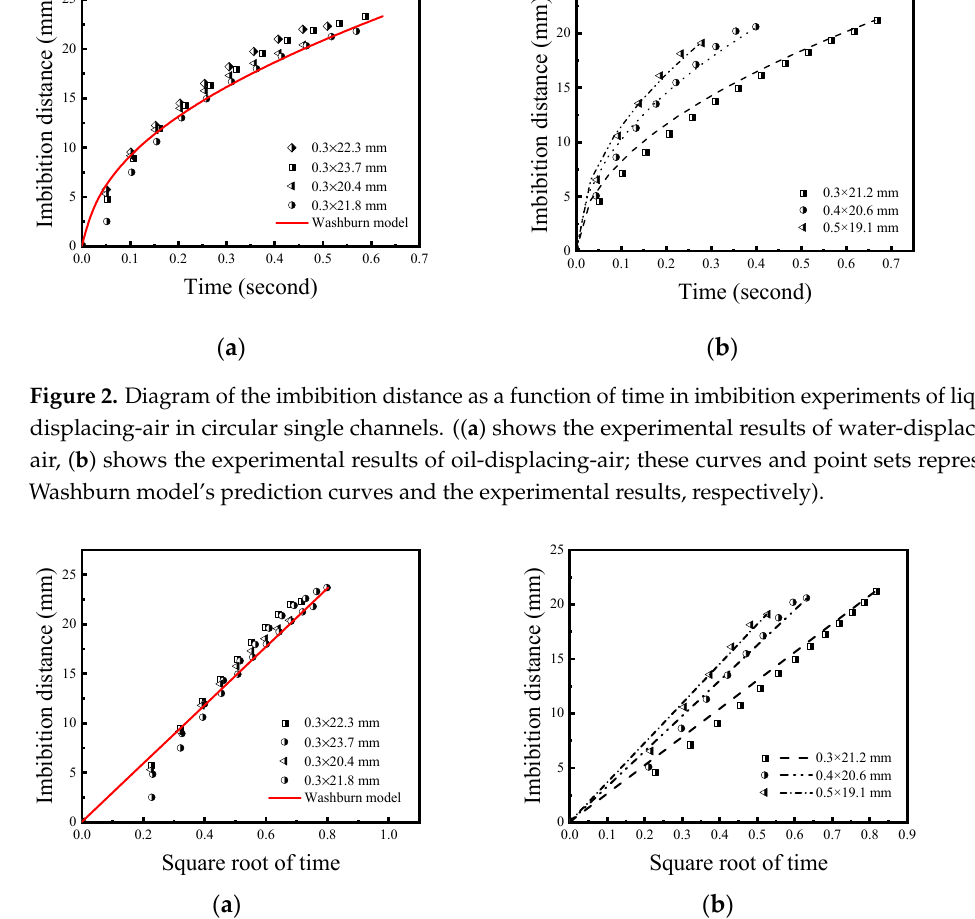
Figure 3. Diagram of the imbibition distance as a function of √𝑡 in imbibition experiments of liquid- displacing-air in circular single channels. (( a ) shows the experimental results of water-displacing- air, ( b ) shows the experimental results of oil-displacing-air; these curves and point sets represent Washburn model’s prediction curves and the experimental results respectively).